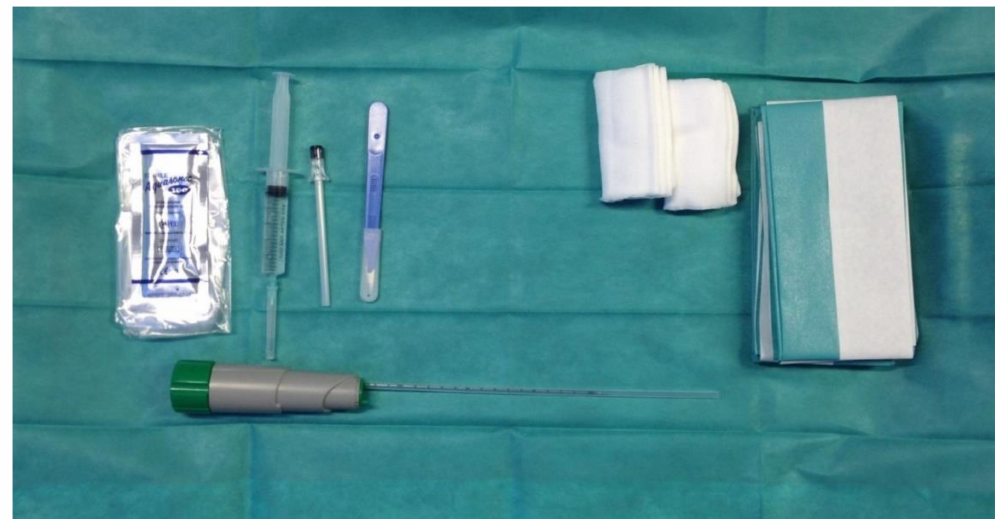
Figure 1. Commercially available renal biopsy kit, consisting of an automatic spring-loaded biopsy system with an 18 G needle and a 1 or 2 cm slit, sterile drapes, sterile gauze, sterile ultrasound gel, a syringe and needle for anesthesia, a scalpel, and a swab for surface disinfection.